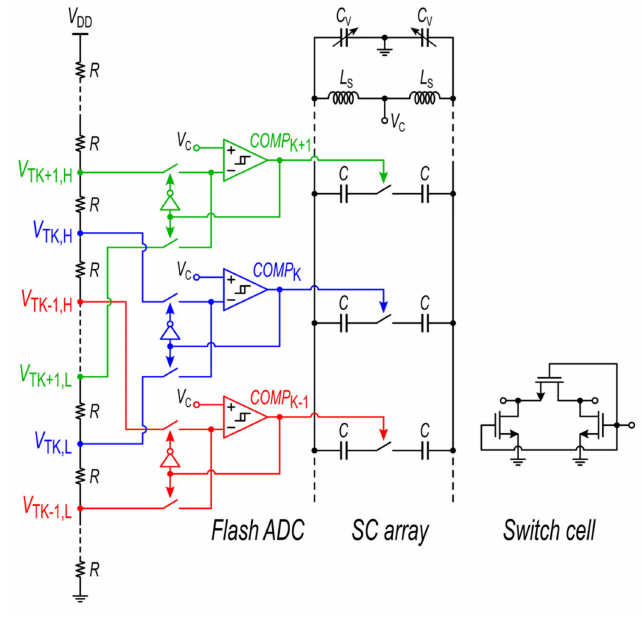
Figure 3. Simplified schematic of the proposed tuning circuit.